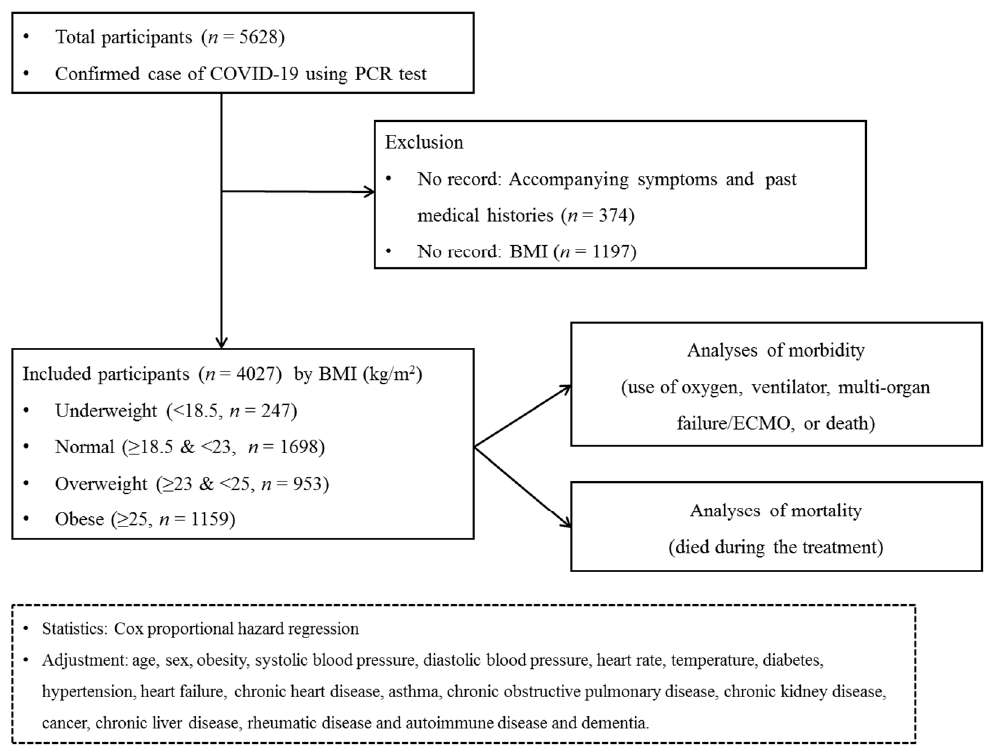
Figure 1. A schematic illustration of the participant selection process that was used in the present study. Of a total of 5628 patients with confirmed COVID-19, 247 underweight participants, 1698 normal participants, 953 overweight participants and 1159 obese participants were selected.